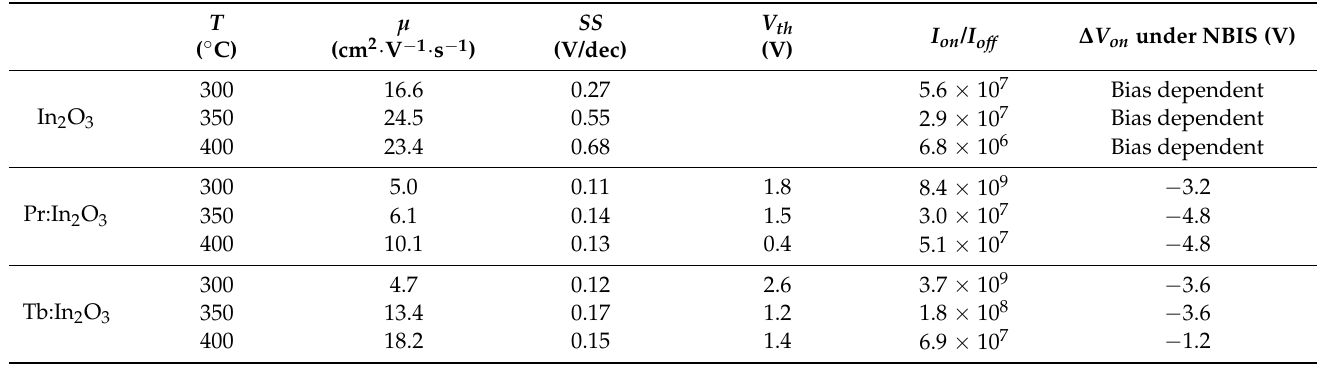
Table 1. Summary of the properties of the Pr/Tb:In 2 O 3 TFTs with different annealing